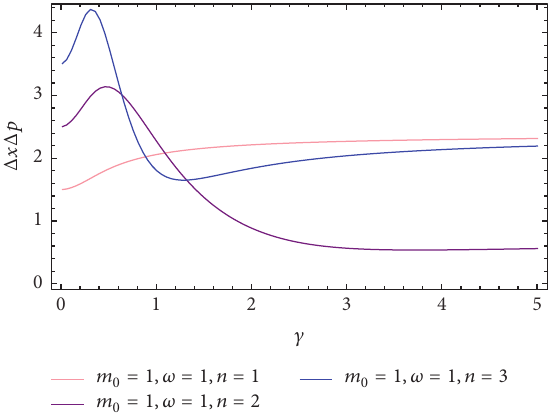
Figure 12: Combined uncertainty versus 𝛾 .